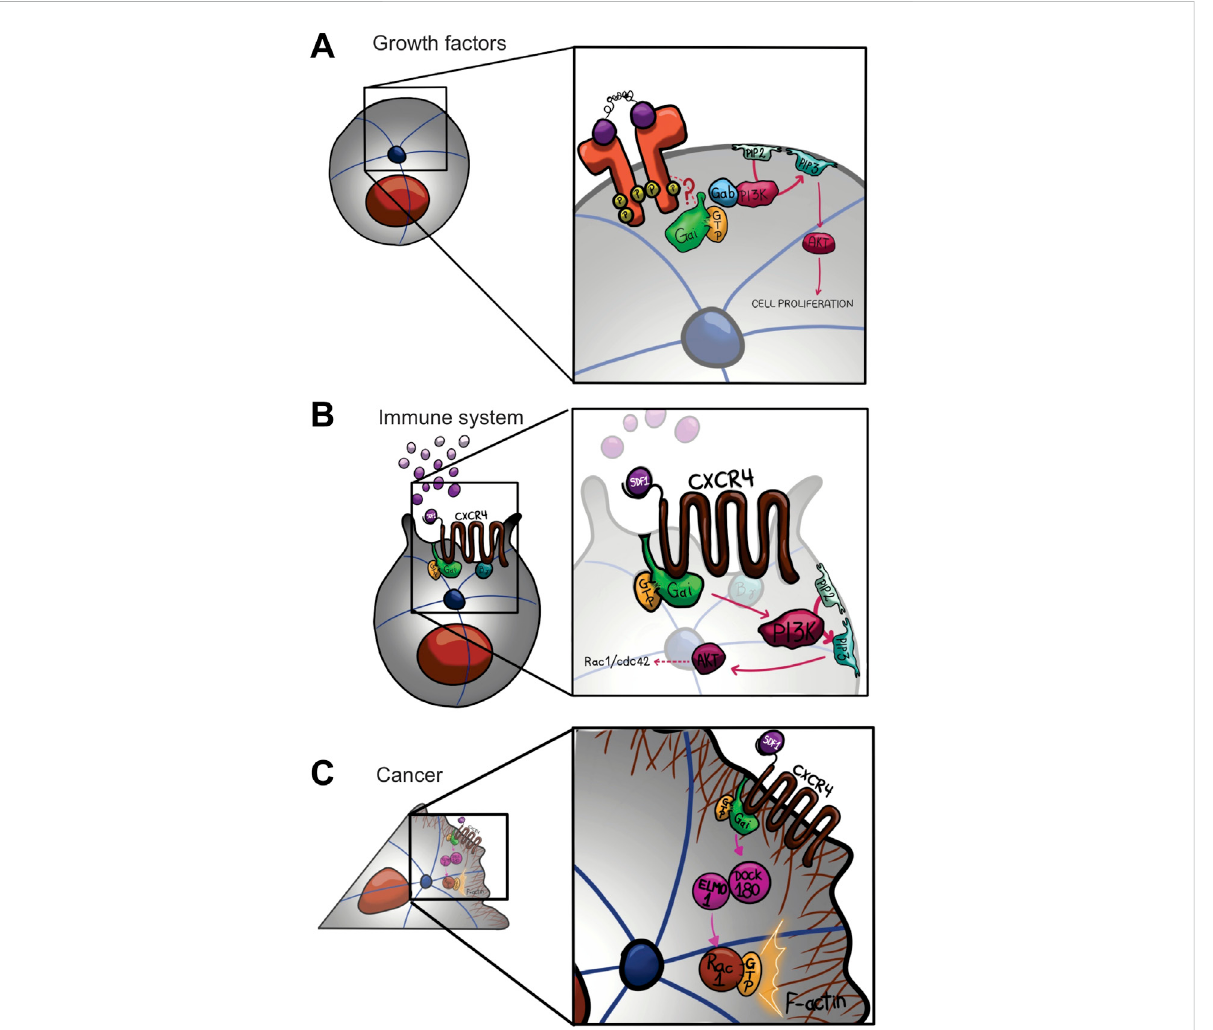
FIGURE 3 G α i non-canonical signaling network models that show regulation of cell proliferation (A) , cell migration in immune system (B) and cancer (C) . There are multiple integrated pathways and crosstalk between Gi and tyrosine kinases signaling pathways regulating cell proliferation, growth, migration,andsurvival.Allprocessesinduceduponactivationofreceptortyrosinekinases(RTKs),includingepidermalgrowthfactorreceptor(EGFR), fi broblast growth factorreceptor(FGFR),vascularendothelial growth factor receptor (VEGFR), and keratinocyte growth factor receptor (KGFR), activating PI3K-AKT pathway. RTK upon activation by its ligand is coupled to G α i by an unknown mechanism, promoting the activation of PI3K-AKT signaling by G α i/Gab interaction (A) . On another hand, CXCR4 (C-X-C chemokine receptor type 4) activated by SDF-1 is coupled to G α i, promoting the activation of PI3K-AKT signaling accumulating D3-phosphoinositol lipids (B) . Finally, during invasive migration in breast cancer cells, G α i2 in response to the same ligand, SDF-1, regulates the activation of Rac proteins through Elmo1/Dock180 interaction, contributing on the actin polymerization and migration (C)